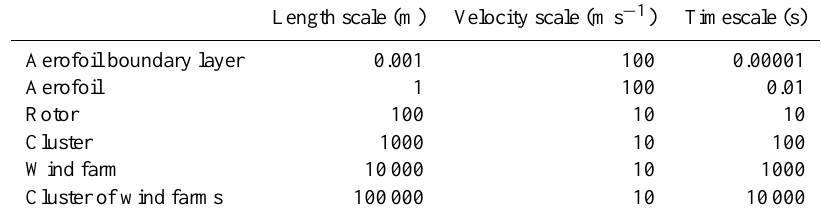
Table 1. Scale requirements in wind turbine